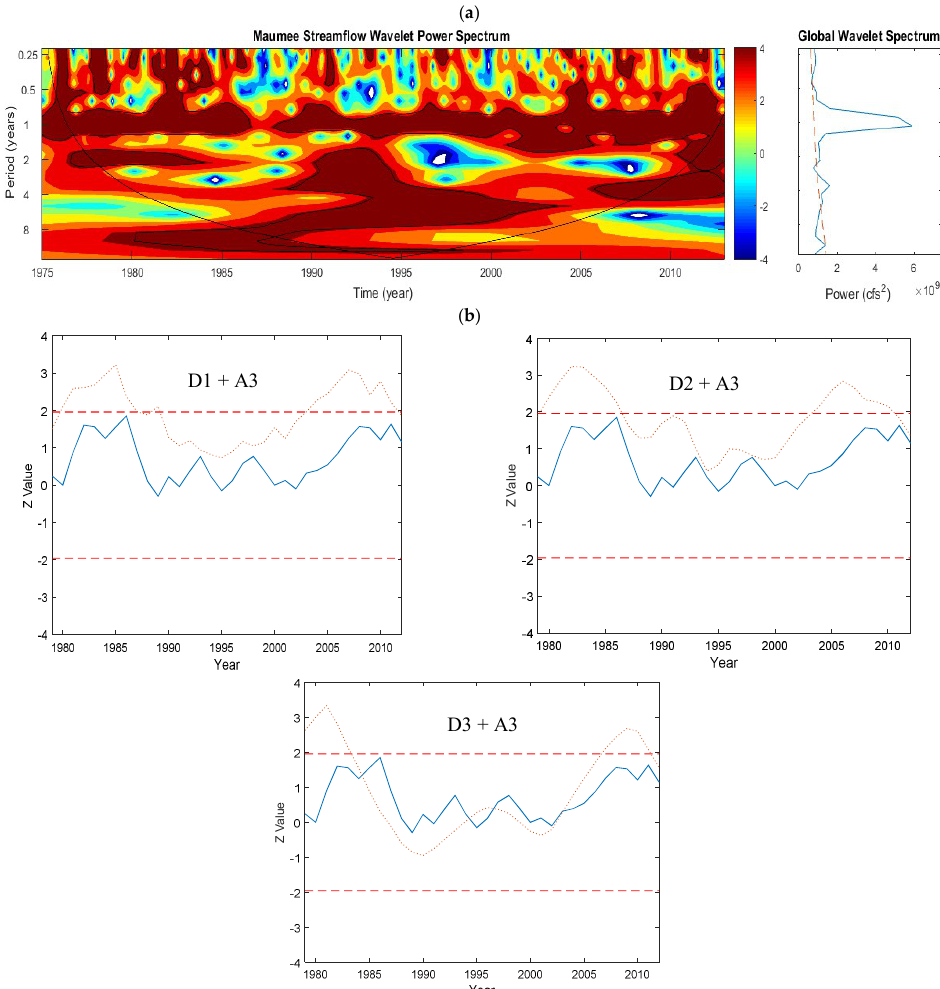
Figure 8. Maumee River: ( a ) Continuous wavelet transform on a daily basis. ( b ) Plots of the sequential Mann–Kendall analyses on the Details (with added Approximation component) of the annual streamflow data. The top and bottom dashed lines are ±1.96, which are the confidence limits of the MK test using α = 5%. The solid and dotted lines show the sequential MK values for the original data and the Detail components, respectively. For this streamflow data, the D2 (4 years) and D3 (8 years) components were the most effective periodic oscillation.